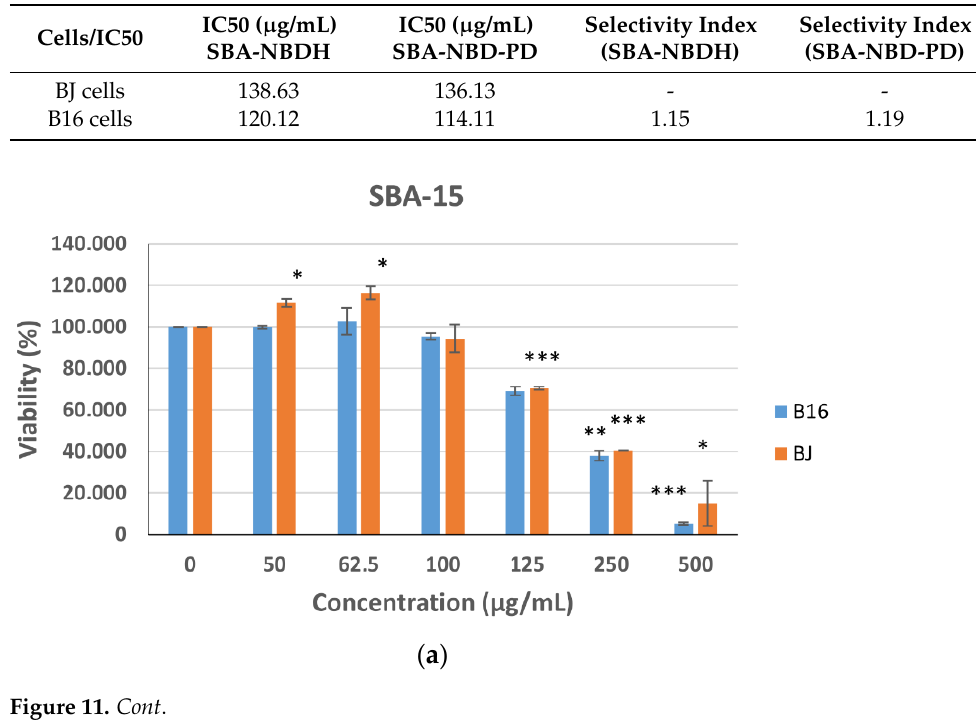
Figure 10. Antioxidant activity by DPPH assay of the SBA-15 with NBD derivatives.